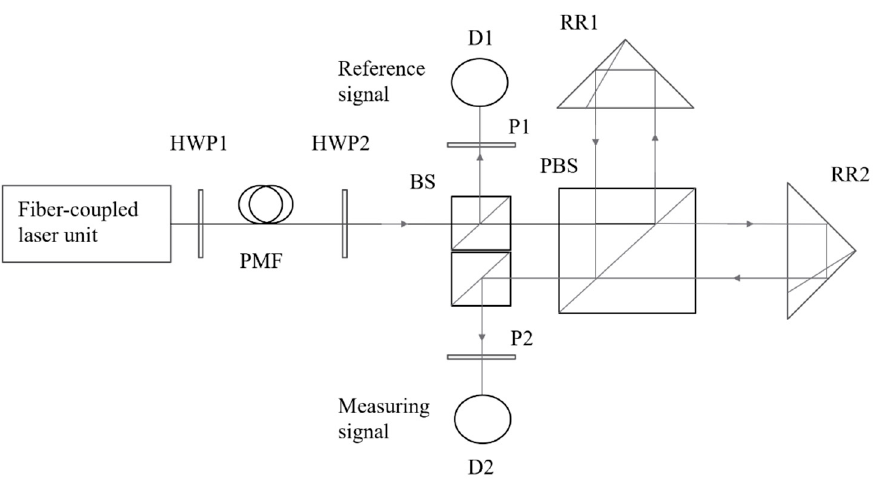
Figure 8. Schematic of a heterodyne measurement system based on one single-mode PMF. A reference signal detector is placed after the fiber to get rid of the phase error caused by the fi ber.